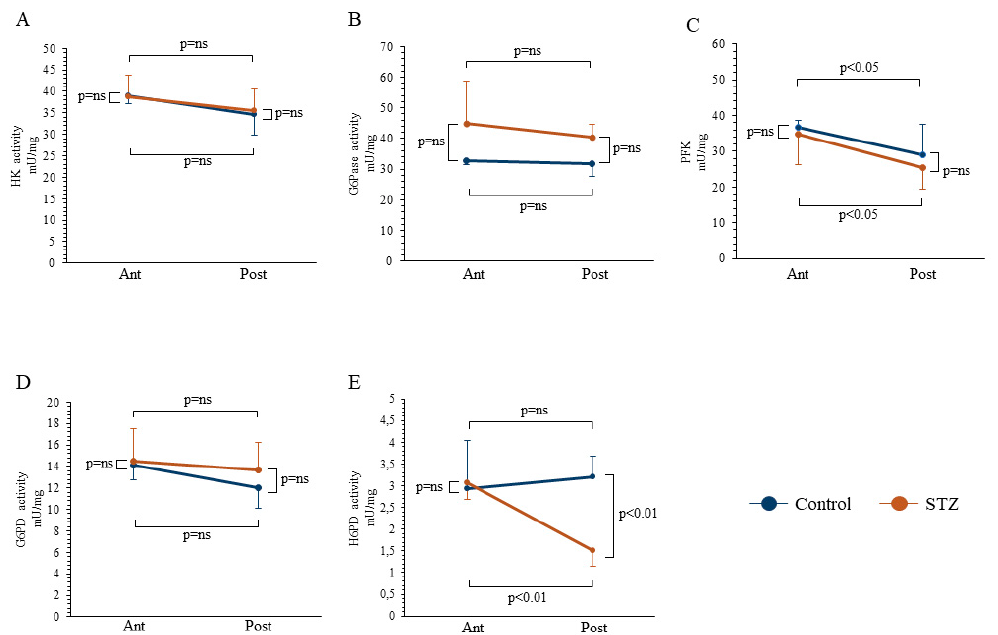
Figure 3. E ff ect of STZ treatment on enzymatic pathway of glucose degradation. Catalytic activities of hexose-kinase (HK, Panel A ), glucose-6-phosphatase (G6Pase, Panel B ), Phosphofructokinase Figure 3. Effect of STZ treatment on enzymatic pathway of glucose degradation. Catalytic (PFK, Panel C ), glucose-6-phosphate dehydrogenase (G6PD, Panel D ), and hexose-6-phosphate dehydrogenase (H6PD, Panel E ) in anterior (Ant) and posterior (Post) brain areas in control ( n = 6 for each area, blue) and STZ mice ( n = 6 for each area, brown). STZ treatment significantly reduced H6PD catalytic function in posterior brain areas, while it did not a ff ect the main enzymes involved in glucose entrapment, release, and cytosolic catabolism. Data are expressed as mean ±